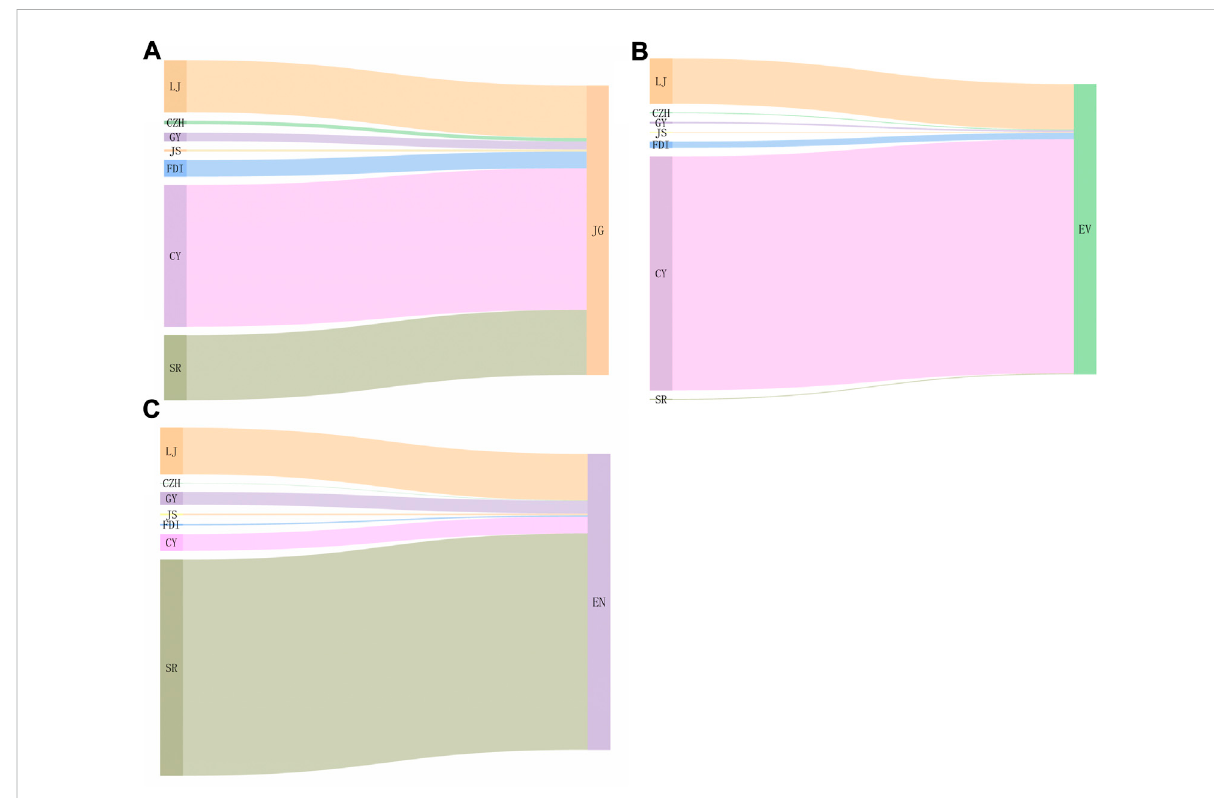
FIGURE 7 Impact of green fi nance on high-quality economic development, environmental pollution, and energy consumption after adding control variables (see Supplementary Table S5 for detailed